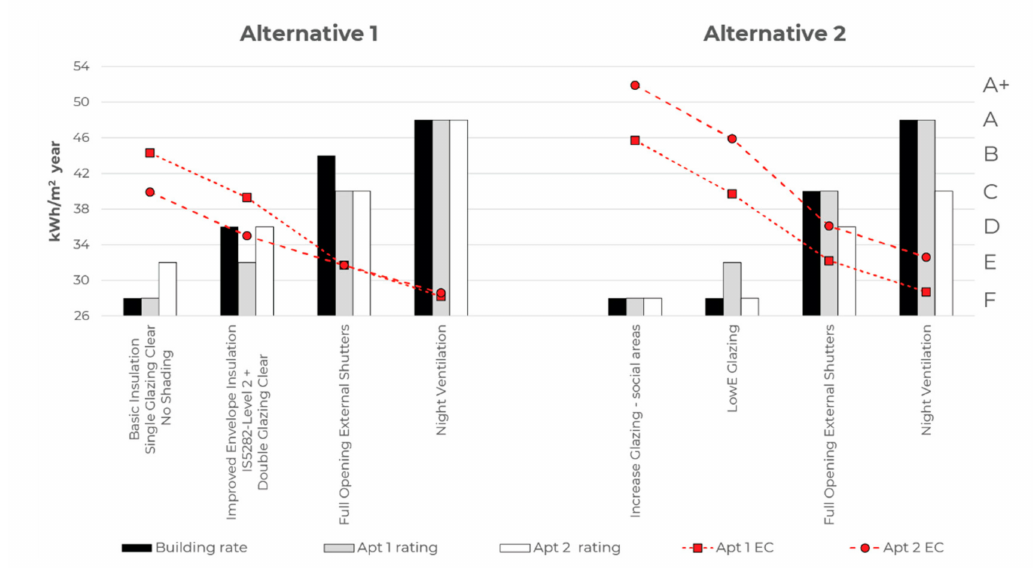
Figure 12. Case study building 2: Energy consumption and rating of design alternatives during the design